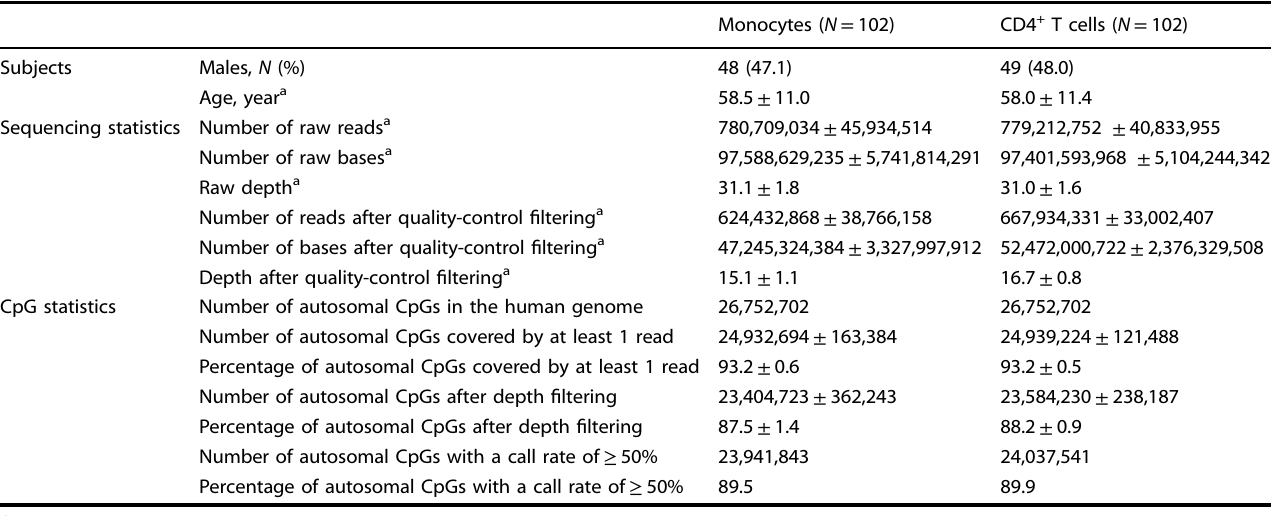
Table 1. Statistics for WGBS-based DNAm pro fi